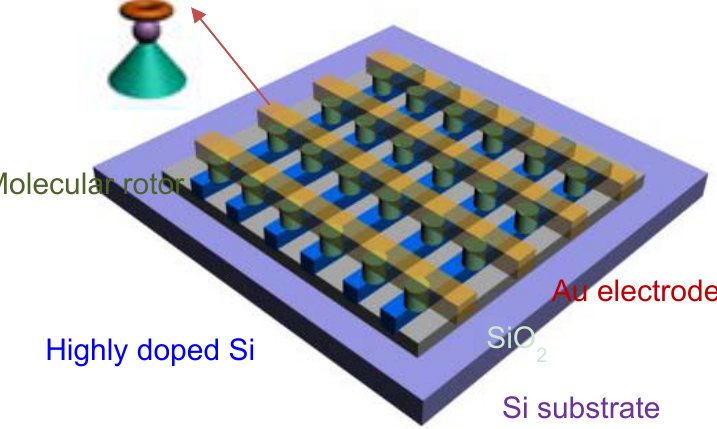
Figure 10. Schematic view of a nanoelectronic crossbar architecture. Junctions (molecular switch) may be independently configured to behave as electronic devices.